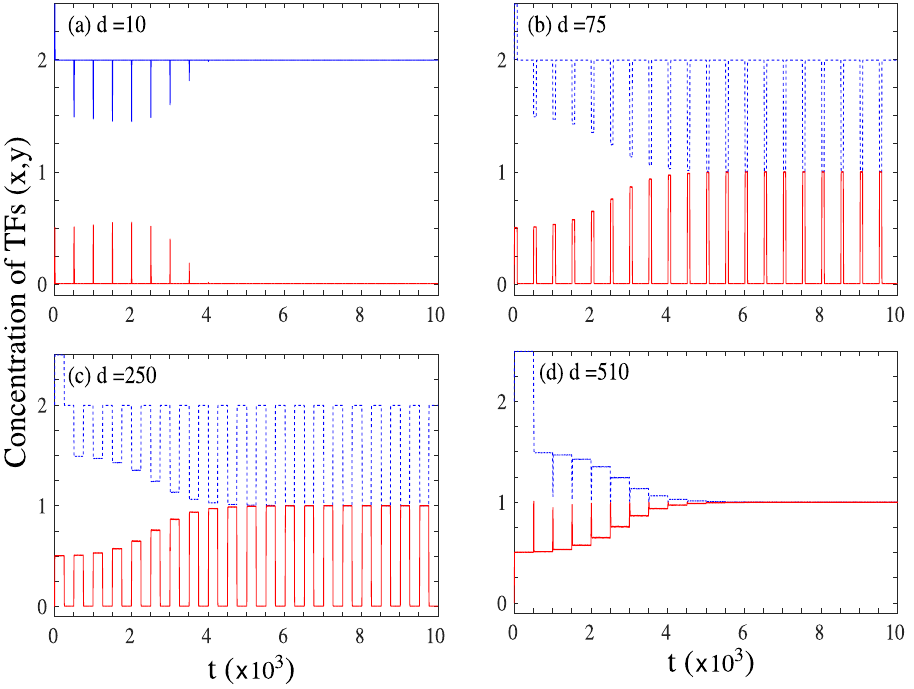
Figure 2. Time series of the concentrations of the two transcription factors ( x / y ) in regime A for four different drive times for τ = τ 1 = τ 2 = 500. ( a ) d = 10: System stays in initial undifferentiated state; ( b ) d = 75: Sustained oscillations with the system spending more time in the vicinity of one state than the other; ( c ) d = 250: Sustained oscillations with the system spending approximately equal times in the vicinity of the two states; ( d ) d = 510: Successful reprogramming to the undifferentiated